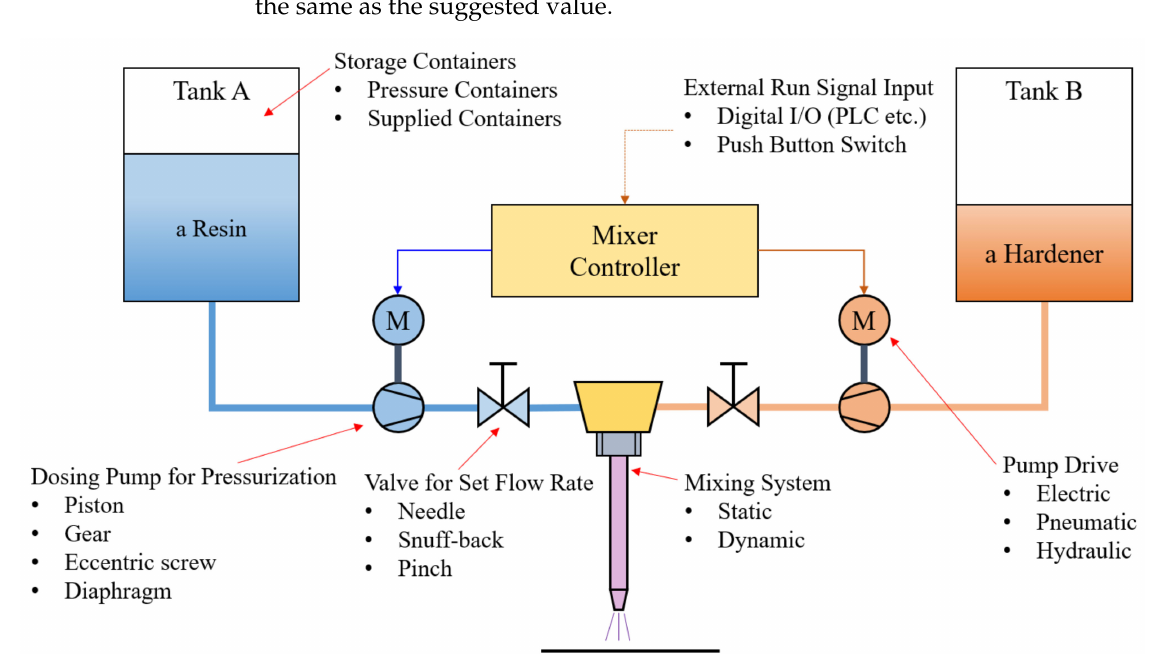
Figure 1. Schematic diagram of a dosing system for two-part epoxy adhesive (modified from